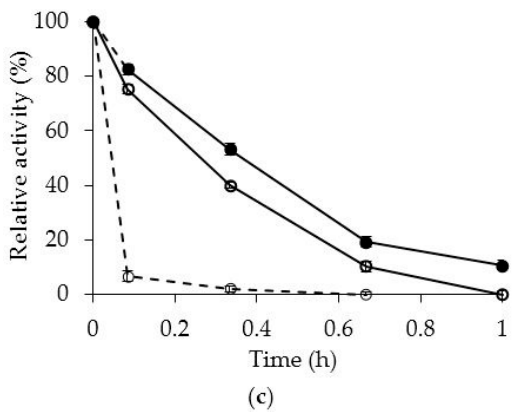
Figure 2. Thermal inactivation courses of the OCCALB and OCCALB-PEI biocatalysts. Panel ( a ): 80 °C and pH 5; panel ( b ): 70 °C and pH 7; panel ( c ): 60 °C and pH 9. Open circles, solid line: OCCALB; closed circles, solid line: OCCALB PEI; dashed line: free CALB.